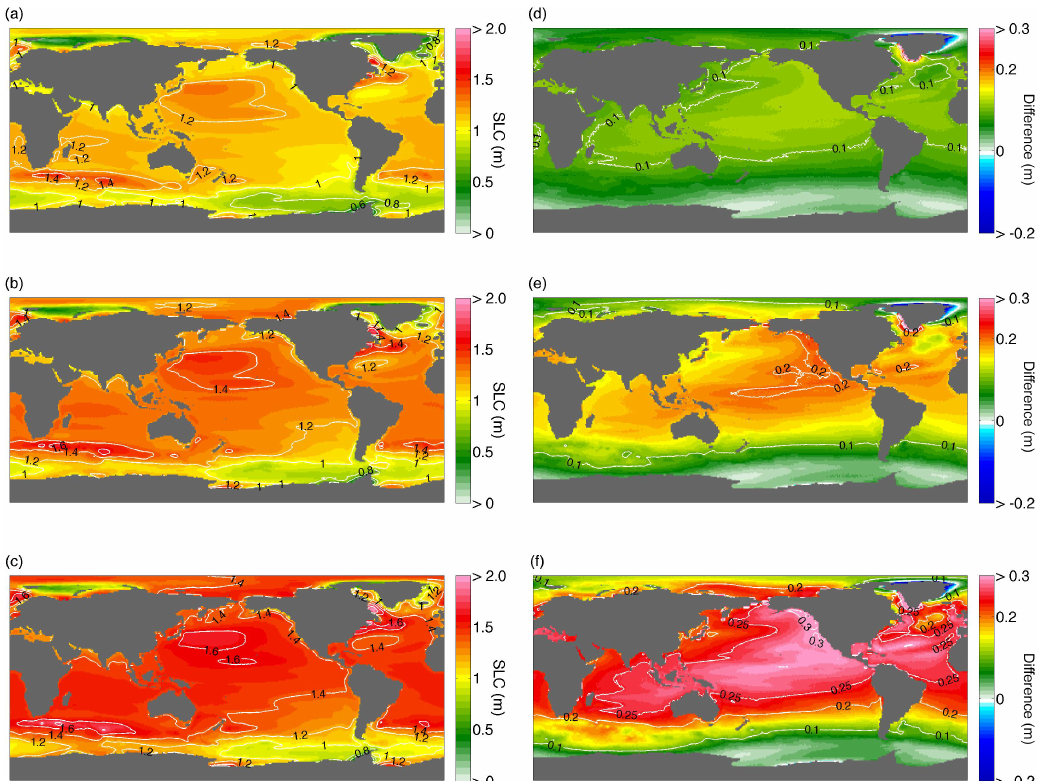
Figure 7. Sea level change (SLC) projections by 2090 for high-end percentiles corrected with shift in local median. Left column: (a) 90th, (b) 95th and (c) 97.5th percentile for the asymmetric VW15 distribution of ice sheet mass loss combined with regional SLC projections following RCP8.5 (Slangen et al., 2014), corrected with the local shift in median depicted in Fig. 3c. Right column: difference between the asymmetric VW15 (corrected with the difference in local median) and symmetric IPCC-based (both combined with regional SLC projections following RCP8.5; Slangen et al., 2014) for the (d) 90th, (e) 95th and (f) 97.5th